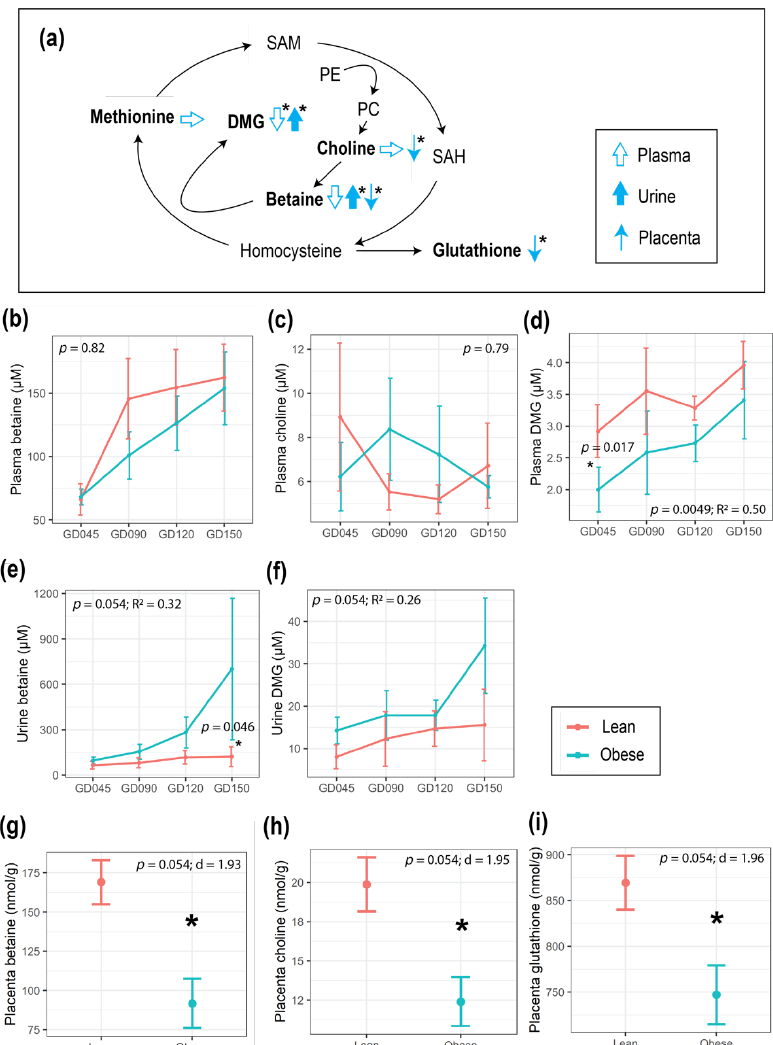
Figure 3. Impact of maternal obesity on one-carbon metabolism that was reflected in the plasma and urine metabolomes during pregnancy. ( a ) Schematic summary of the trends that were found in the metabolites of the one-carbon metabolism pathway, where the arrow indicates an increase (up), decrease (down) or no difference (horizontal) in mothers in the Obese group compared to the Lean group. Plasma is indicated with an open arrow, urine with a solid arrow, and placenta with a thin arrow. Metabolites that were profiled in this study are in bold. ( b – i ) Line plots showing the concentration of plasma ( b ) choline, ( c ) betaine, ( d ) DMG; urinary ( e ) betaine, ( f ) DMG; placental ( g ) choline, ( h ) betaine, and ( i ) glutathione (mean ± SE). A linear mixed-effects model was fitted followed by an ANOVA to test the group difference in the concentrations of plasma and urine metabolites, and pairwise comparison was done as a post hoc test using the estimated marginal means. t -tests were used to test for group differences in the concentrations of placental metabolites. The red and blue lines correspond to the Lean and Obese groups, respectively. Statistical significance is indicated with “*”. The sample size of plasma samples are: Lean ( n = 4 at GD45 & GD90, n = 5 at GD120, n = 6 at GD150) and Obese ( n = 7); urine samples are Lean ( n = 4 at GD45 & GD90 & GD150, n = 5 at GD120) and Obese ( n = 7); and placental samples are Lean ( n = 2) and Obese ( n = 4). Abbreviations: d or R 2 , effect size measurements; GD, gestational day; DMG, N,N-dimethylglycine; SAM, S-adenosylmethionine; PE, phosphatidylethanolamine; PC, Phosphatidylcholine; SAH, S-adenosylhomocysteine; Eff, effect size; SE, standard